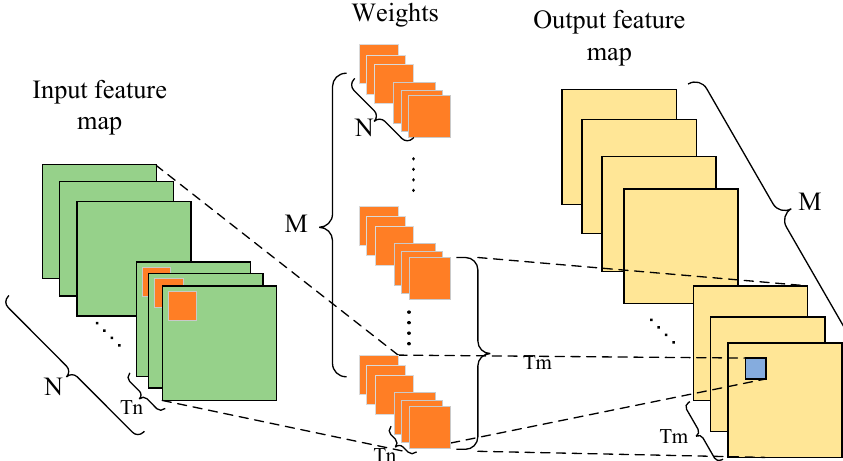
Figure 5. Parallel computation of input and output channels.